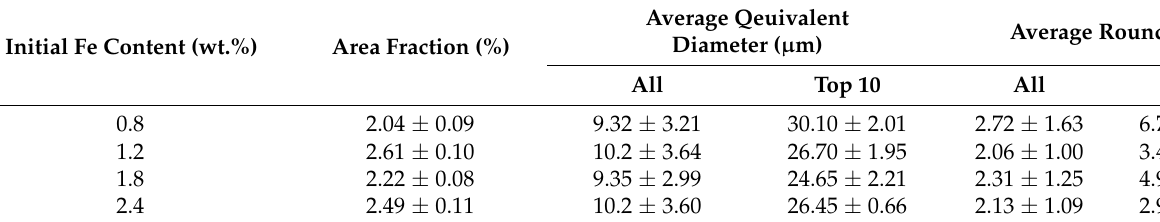
Table 3. The morphological characteristics of the Fe-rich phase in alloy.